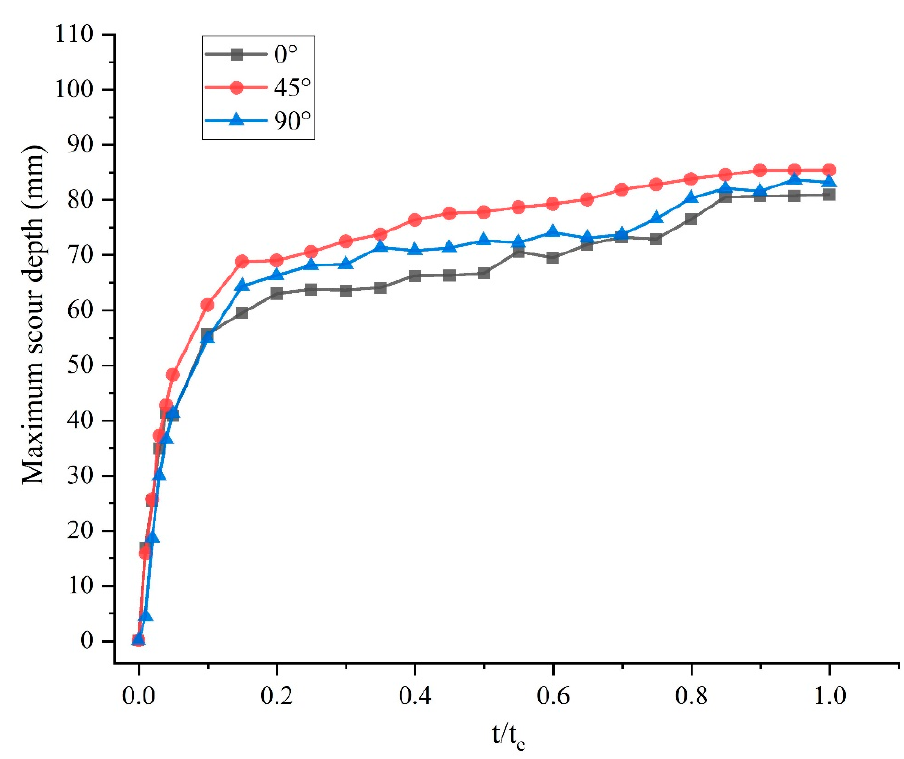
Figure 12. Time history of scour depth at different positions around the pile.